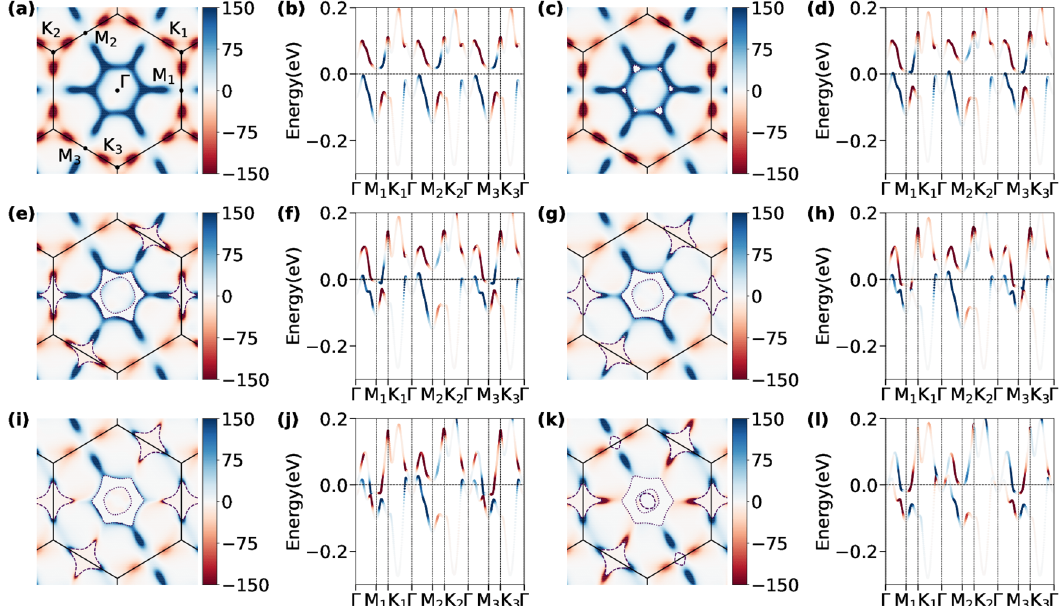
Fig. 6 Spin orientation angle dependent Berry curvature plot. Berry curvatures of occupied Cr e g states in the momentum space (unit in Å 2 ) for spin-orientation angle ( θ ) a θ = 0 ∘ , c θ = 30 ∘ , e θ = 45 ∘ , g θ = 60 ∘ , i θ = 75 ∘ , and k θ = 90 ∘ , respectively. Berry-curvature-projected band structures of Cr e g bands near Fermi level for b θ = 0 ∘ , d θ = 30 ∘ , f θ = 45 ∘ , h θ = 60 ∘ , j θ = 75 ∘ , and l θ = 90 ∘ , respectively. In panel of Berry curvature plots ( a , c , e , g , i , k ), dotted and dashed lines correspond to Fermi surfaces of lowest and second lowest bands of Cr e g bands, respectively. High symmetry points are marked in panel ( a ). Data in all panels is for one electron doping per unit cell and azimuthal angle ϕ = 0 ∘